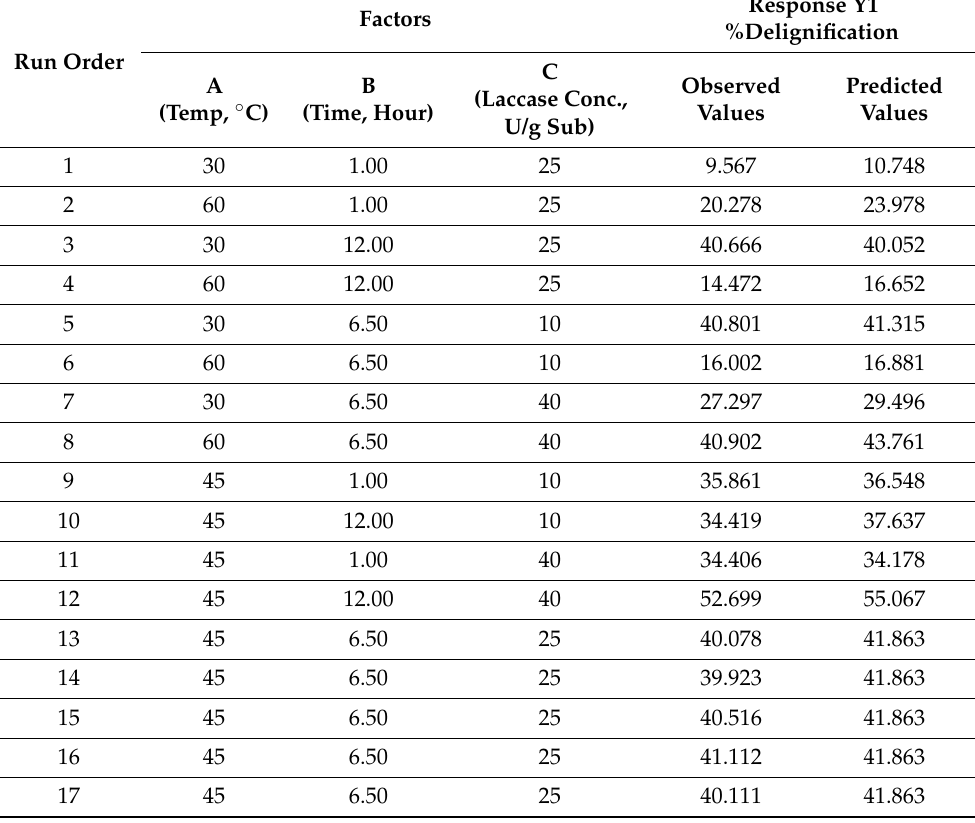
Table 3. Factors of the RSM experimental design. Percentage of delignification as a function of rice straw